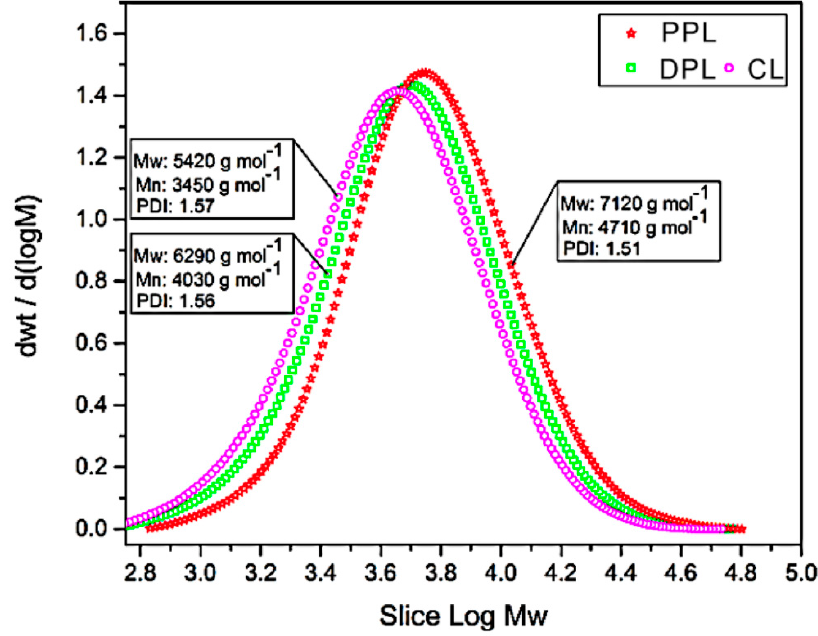
Figure 5. The GPC curves of CL, DPL and PPL samples.